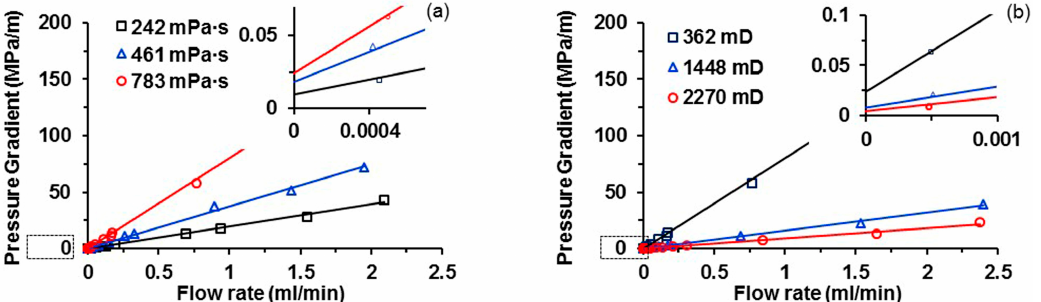
Figure 11. Oil-water two-phase flow curves of heavy oil: ( a ) at different viscosities, k = 362 mD; and ( b ) at different permeabilities, µ o = 783 mPa ·